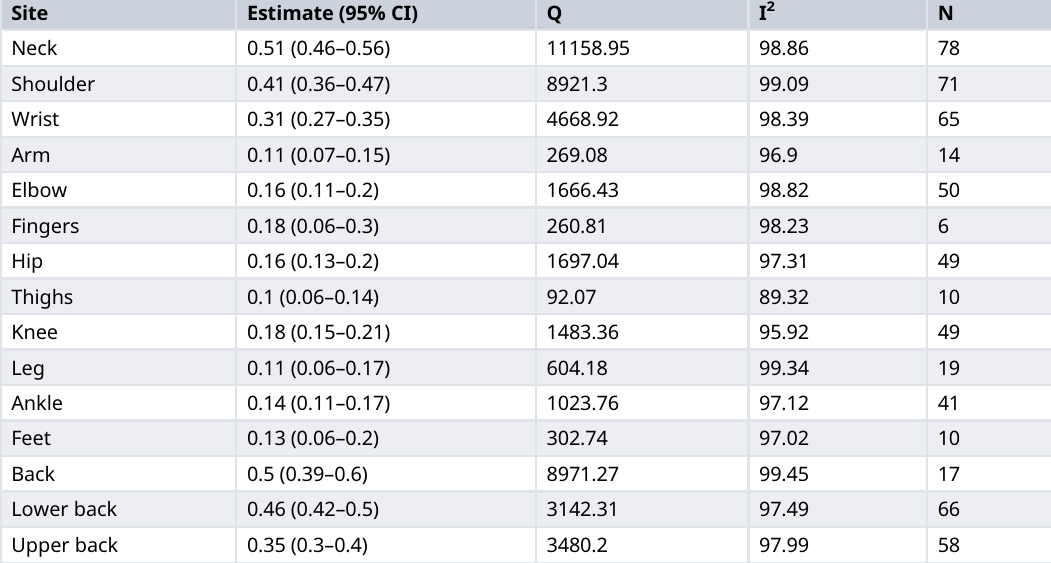
Table 3. Site-specific pooled estimates of overall musculoskeletal